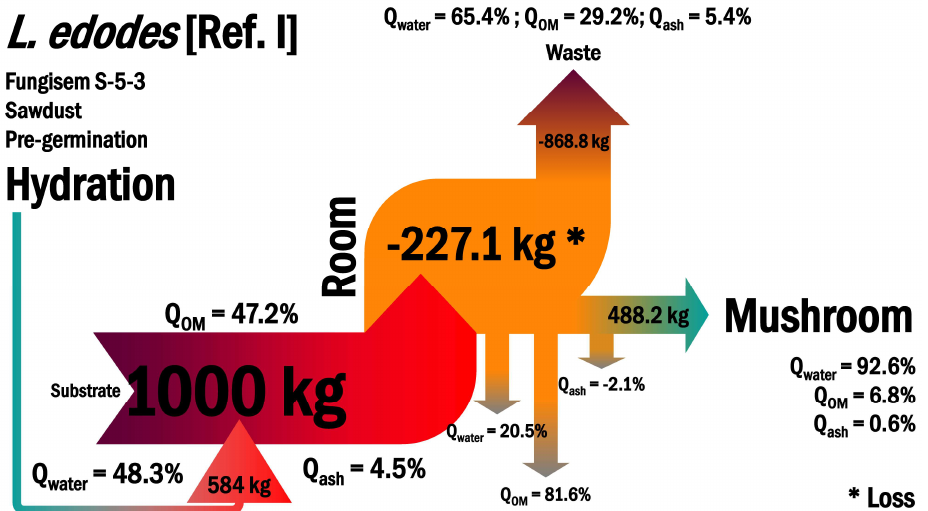
Figure 5. Balance of mass in the system producing L. edodes with the support of hydration to a higher level of bioconversion of the substrate into edible mushrooms. * Refers to a mass loss value in the production room.